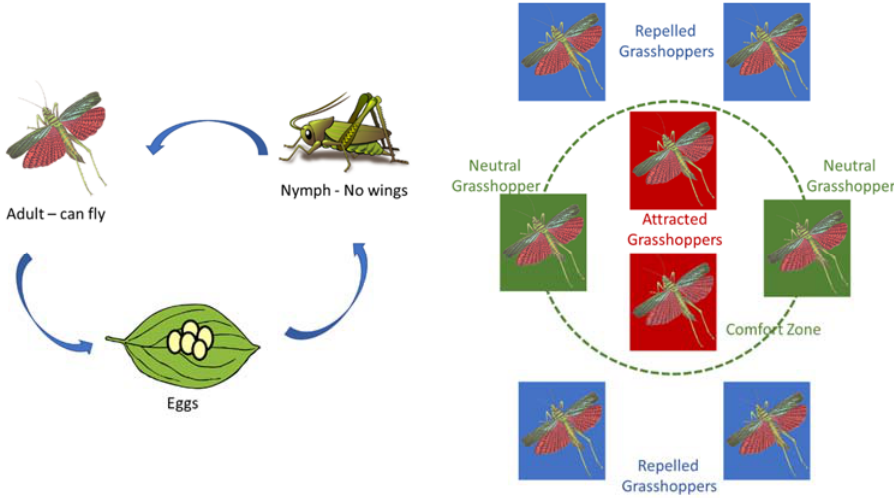
Figure 5. Life cycle of Grasshoppers ( left ) and their social interactions ( right ).